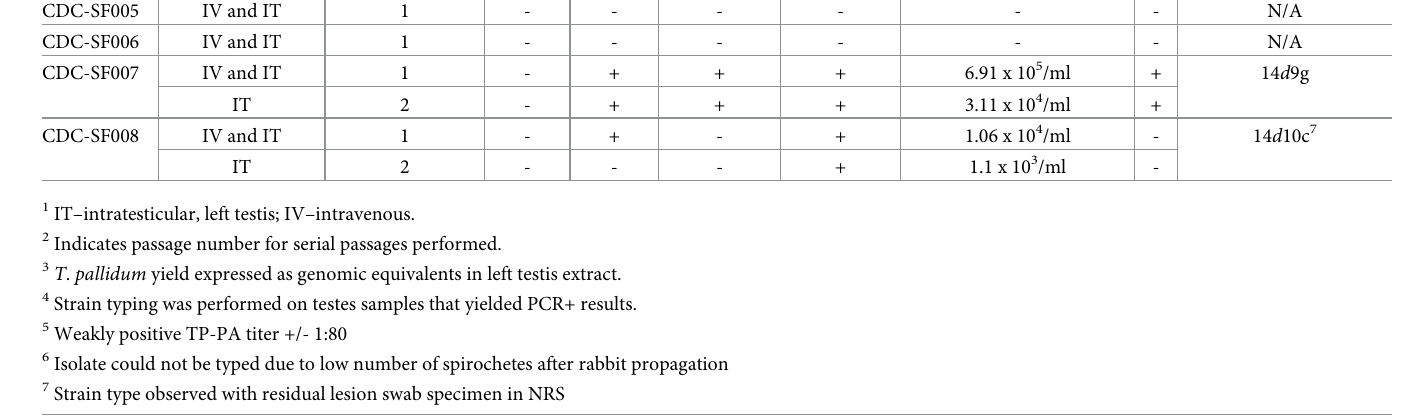
rabbits. Testes specimens at necropsy showed positive qPCR results for the rabbit inoculated with CDC-SF011, indicating an observed T . pallidum genomic equivalent of 64.29 ± 9.22 cop- ies/ml and 0.55 ± 0.13 copies/mg in the left testis extract and tissue, respectively (Table 2). T . pallidum genomic equivalents in the right testis indicated a copy number of 192.86 ± 29.74 per ml and 1.88 ± 0.29 per mg in the extract and tissue. However, there was no evidence of T . palli-